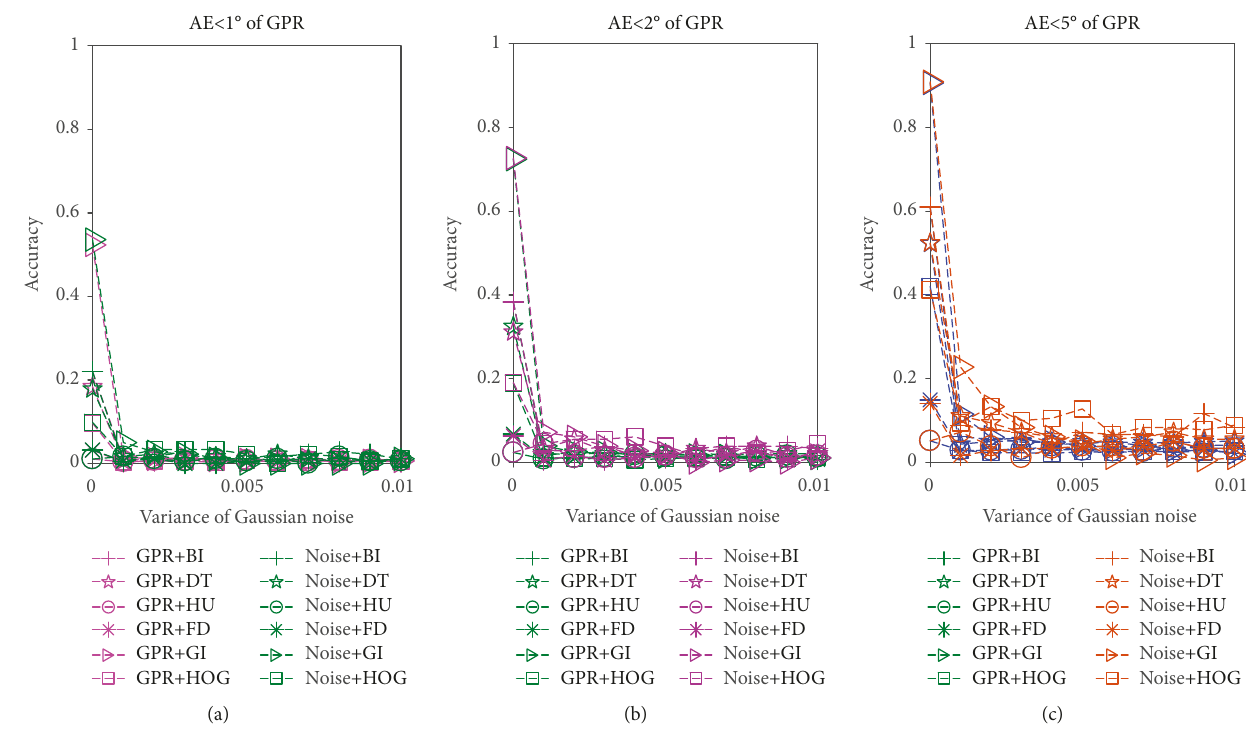
Figure 6: Noise robustness results of GPR for pose estimation (% AE less than a threshold).